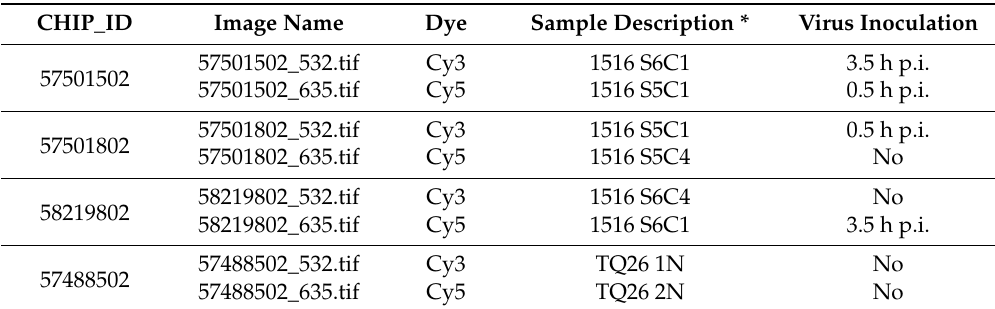
Table 3. Tiling Array hybridization design (081216_Ehux_DS_CGH_HX1) carried out by NimbleGen (design ID 8739, ORD_ID 29312).